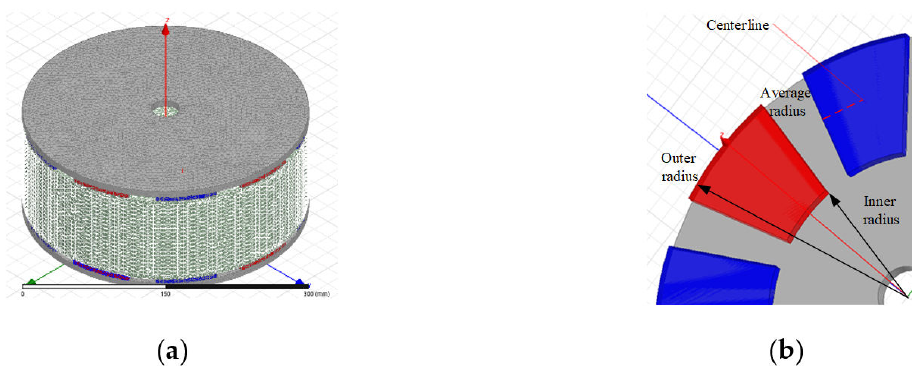
Figure 1. Simplified finite element method (FEM) model: ( a ) 3D model of the simplified axial flux permanent magnet synchronous machine (AFPMSM), and ( b ) model of rotor disk with surface-mounted permanent magnets (PMs) with their dimensions and the position of the centerline on which the axial component of magnetic flux density is analyzed.